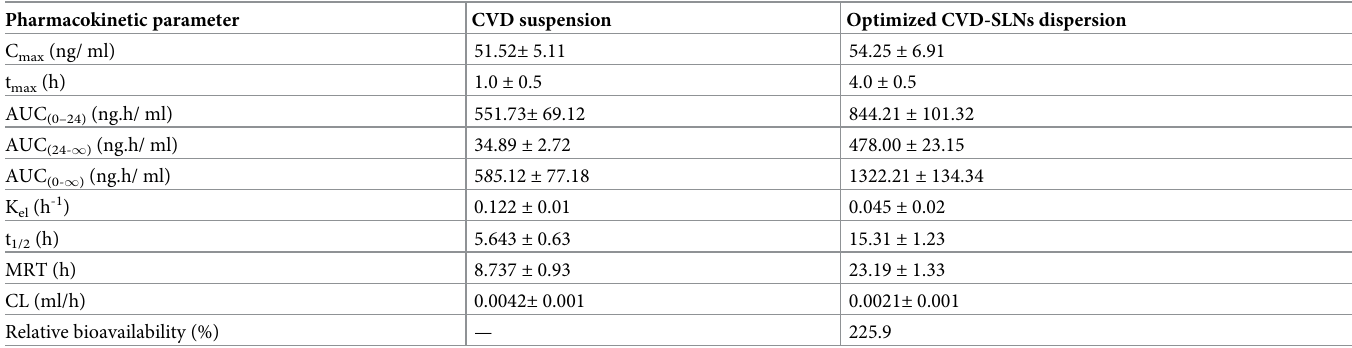
Table 3. Pharmacokinetic parameters of carvedilol following oral administration of the optimized CVD-SLNs dispersion and the drug in suspension. Pharmacokinetic